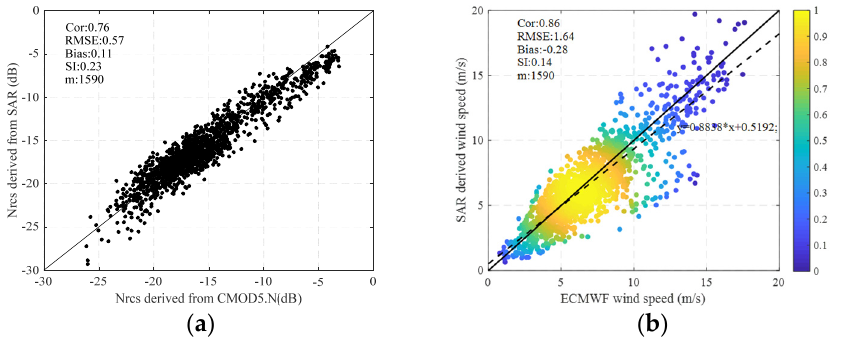
Figure 12. Performance of corrected NRCS on wind speed retrieval: ( a ) NRCS derived from SAR variation relative to CMOD5.N model; ( b ) The SAR-derived wind speed variation relative to ECMWF wind speed.